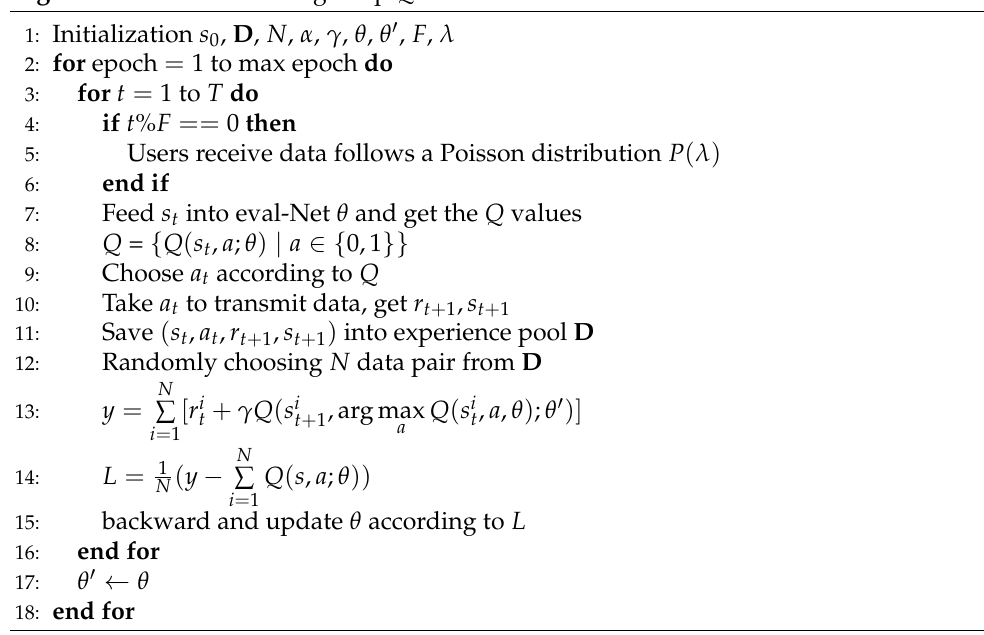
Algorithm 1 Double-dueling-deep Q network.